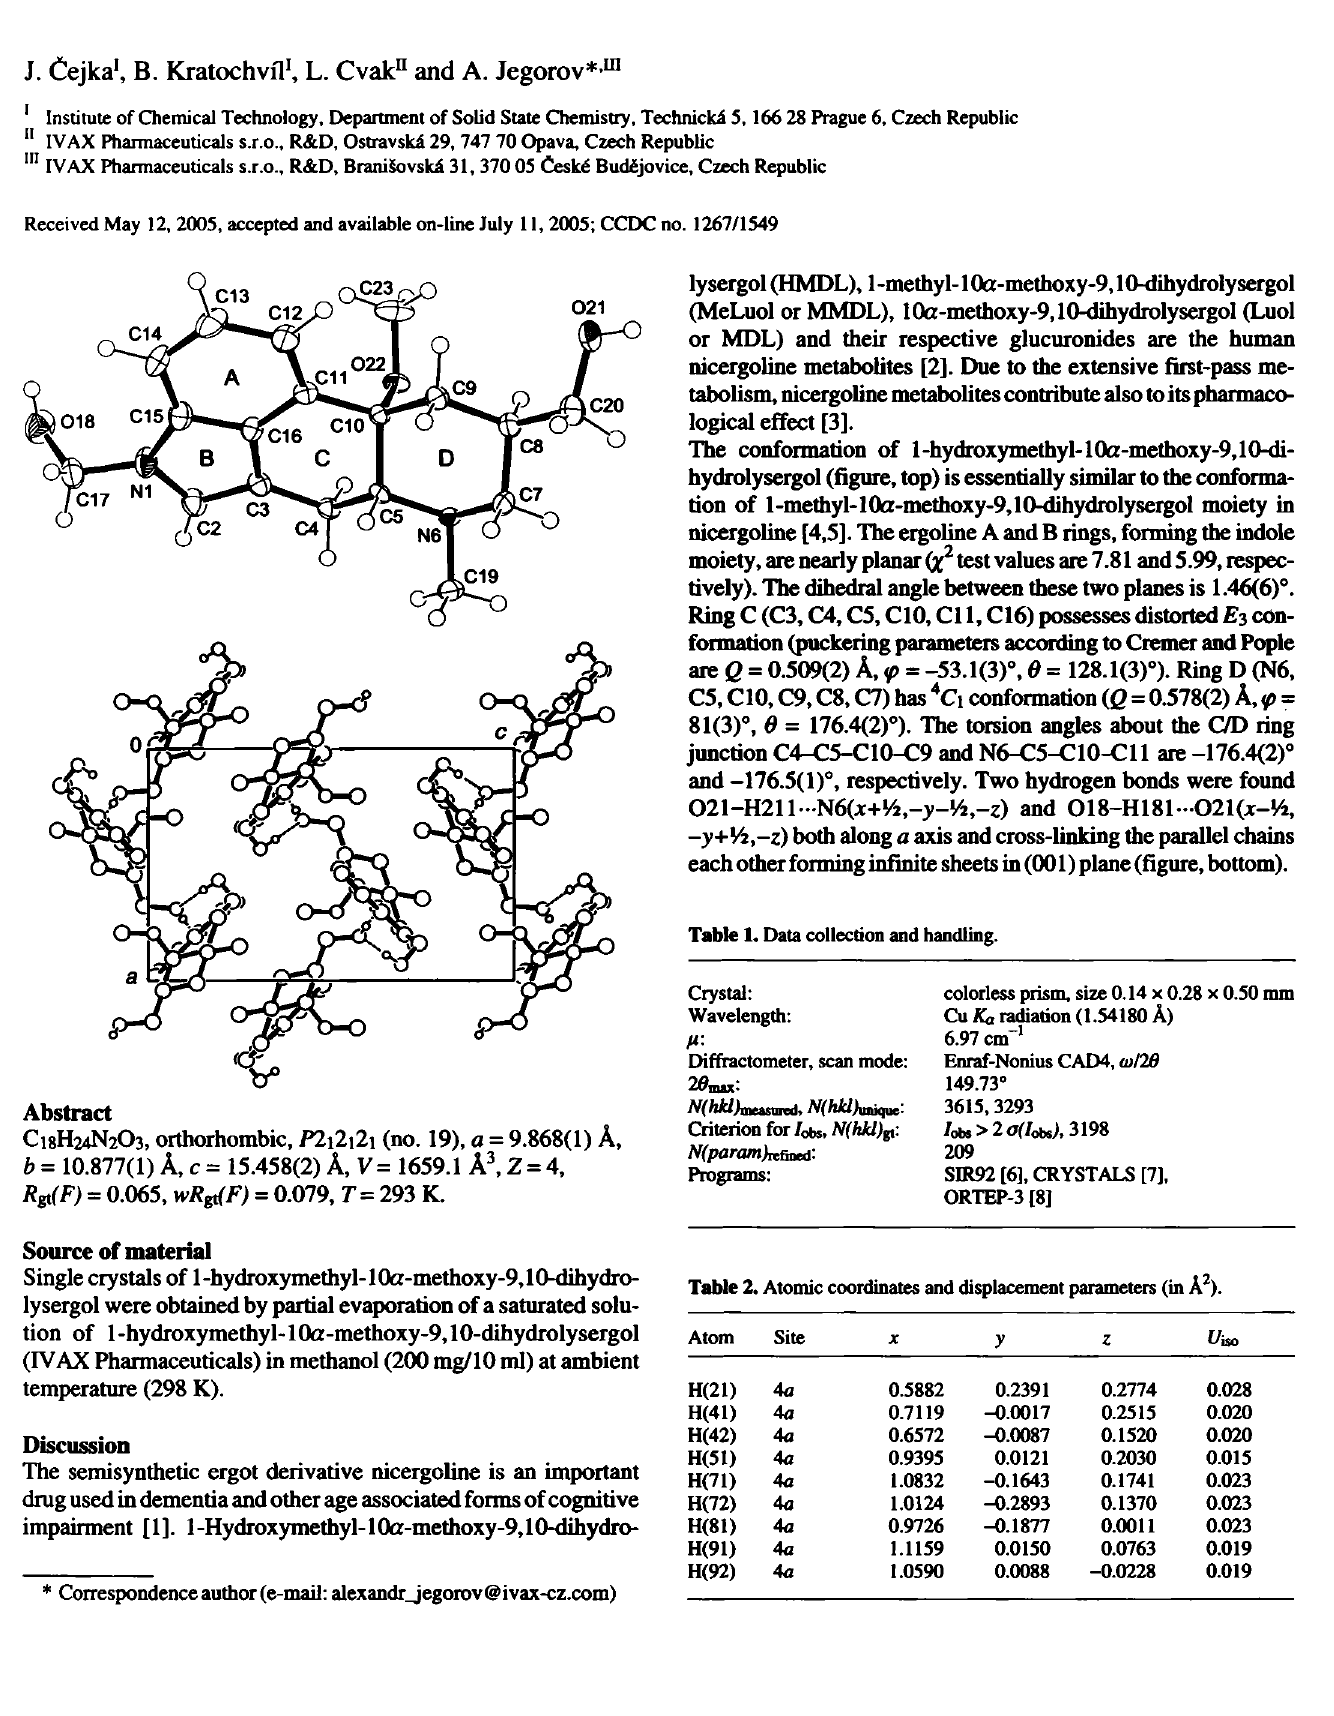
Table 2. Atomic coordinates and displacement parameters (in A 2